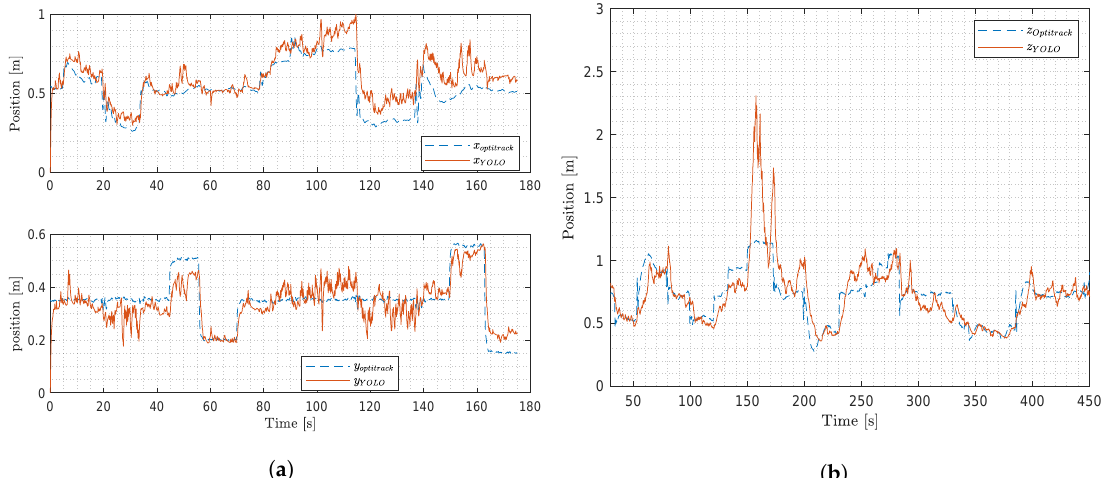
Figure 10. Results from experiments one and two, showing the computed positions and the measured optitrack positions. ( a ) Results from experiment one; ( b ) Results from experiment